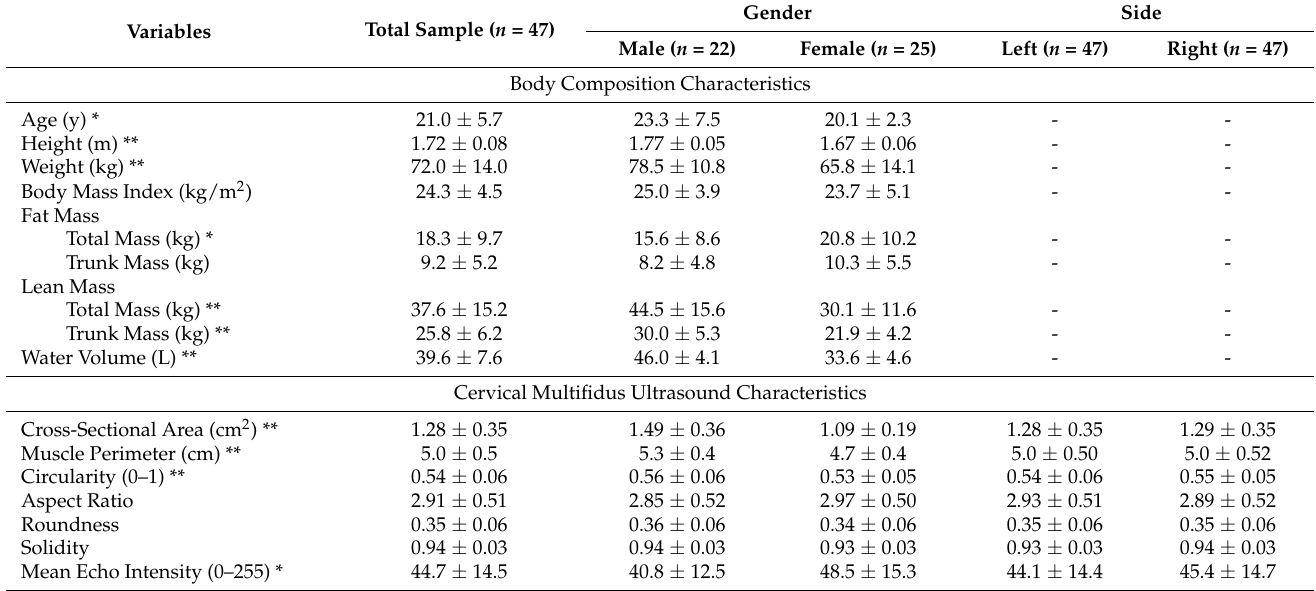
Table 1. Participants’ body composition and US characteristics.